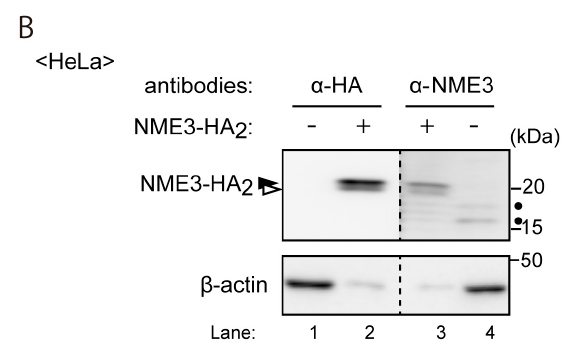
Figure 4. Intracellular localization of NME3-HA 2 in HeLa cells. ( A ) NME3-HA 2 was expressed in HeLa cells. NME3-HA 2 was stained with rabbit anti-HA antibody (green). Peroxisomes and mitochondria were visualized with guinea pig anti-Pex14 (upper panels) and mouse anti-Tom20 (lower panels) antibodies, respectively. Peroxisomes are shown by a pseudo-color image. Scale bar, 10 µm. Higher magnification images of the boxed regions were shown (Inset). Scale bar, 5 µm. Arrowheads indicate peroxisomal, not mitochondrial, localization of NME3-HA 2 . ( B ) immunoblotting of mock- (-) and NME3-HA 2 - (+) transfected HeLa cells. Approximately ten times more of total proteins were loaded in lanes 1 and 4 than those in lanes 2 and 3. NME3-HA 2 was detected with antibodies to HA (upper panel, lanes 1 and 2) and NME3 (ABclonal) (upper panel, lanes 3 and 4). Two bands (solid and open arrowheads) were detected and termed NME3-1-HA 2 and NME3-2-HA 2 , respectively, by the expression of NME3-HA 2 . Dots indicate non-specific bands. β -actin, a loading control.